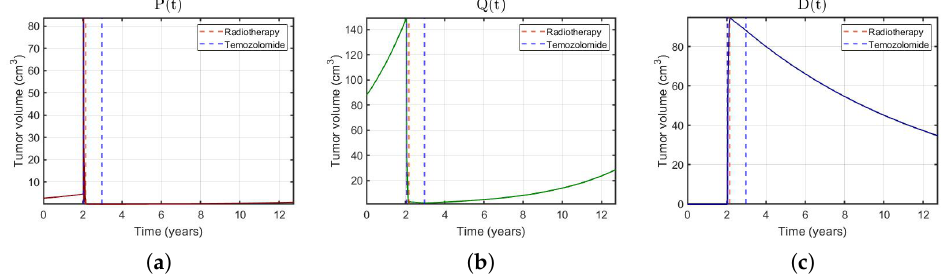
Figure 3. ( a – c ) Evolution of P ( t ) , Q ( t ) and D ( t ) for patient 36. The sum of each of these cell populations corresponds to the total tumor volume.